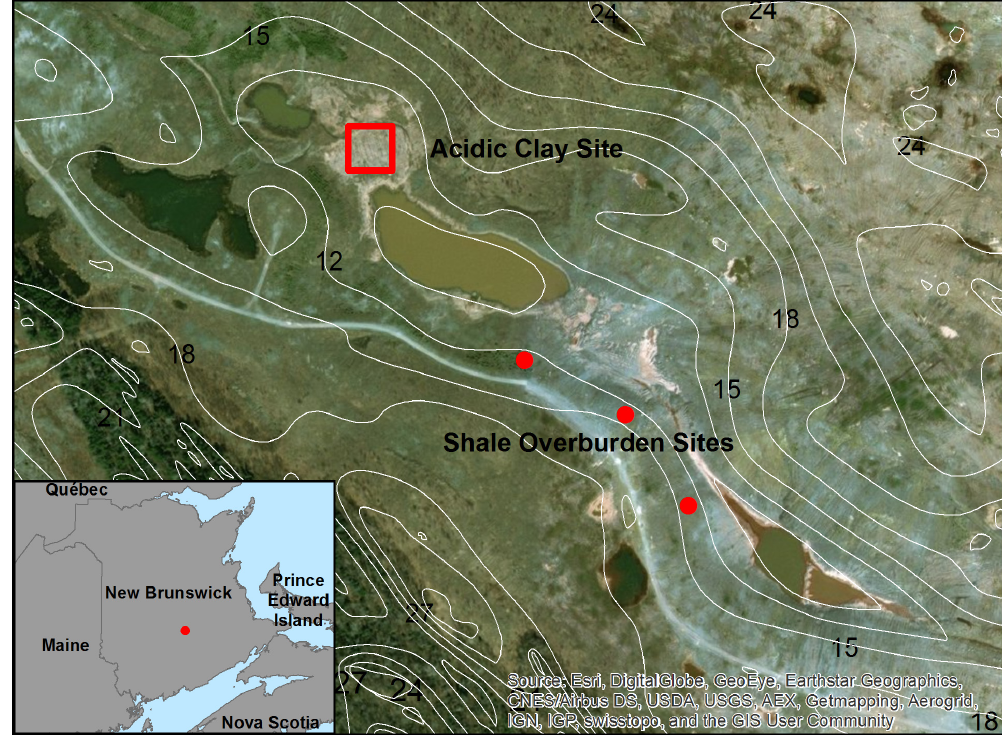
Figure 1. A map of the former Salmon Harbour coal mine site showing the locations of the acidic clay site (red square) and the three sampled sites (red dots) on the adjacent shale overburden. The insert shows the location of the coal mine site in New Brunswick, Canada.